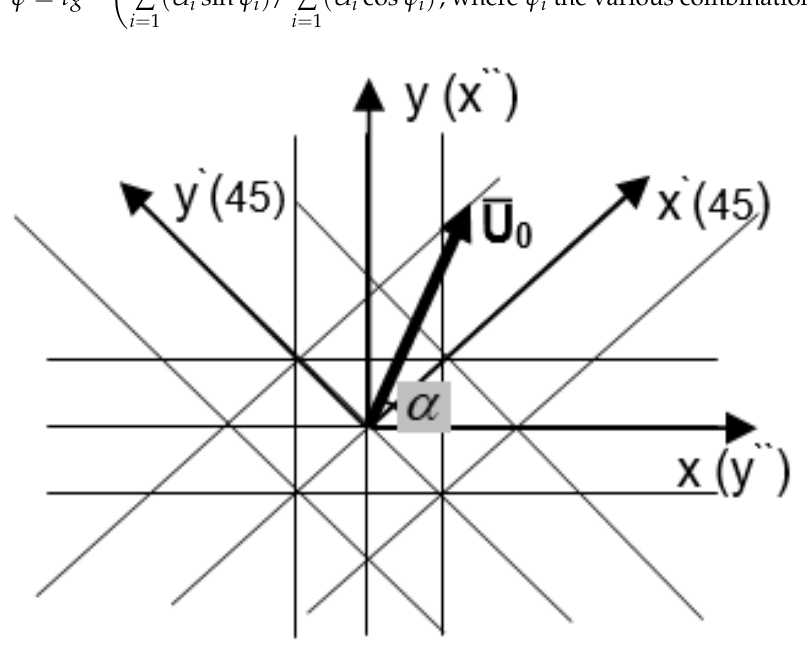
Figure 20. Birefringence in ( 0° + 45° − 45° − 90°) composite laminate.